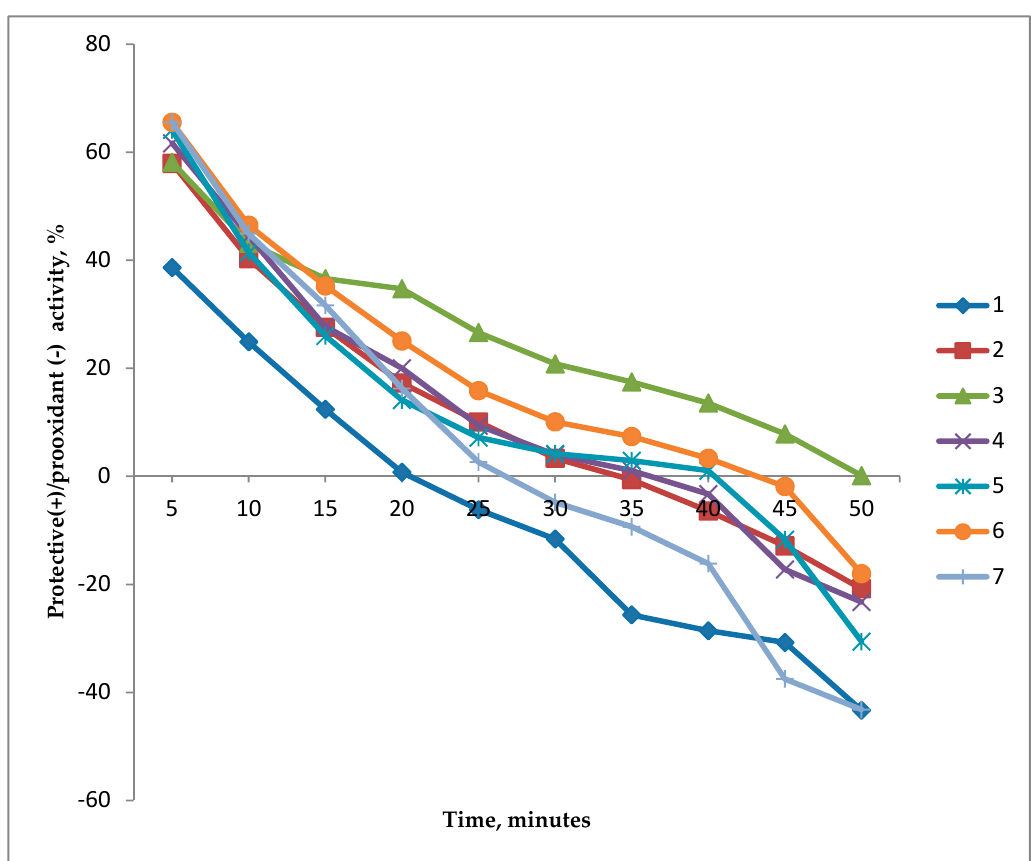
Figure 3. Comparative dynamics of the protective and prooxidant effects of C 60 , measured between 5 and 50 min after beginning of the experiment, %. 1: Fullerene C 60 in a concentration of 10 − 15 g / L; 2: C 60 10 − 12 g / L; 3: C 60 10 − 9 g / L; 4: C 60 10 − 6 g / L; 5: C 60 10 − 5 g / L; 6: C 60 10 − 4 g / L; 7: C 60 10 − 3 g / L.